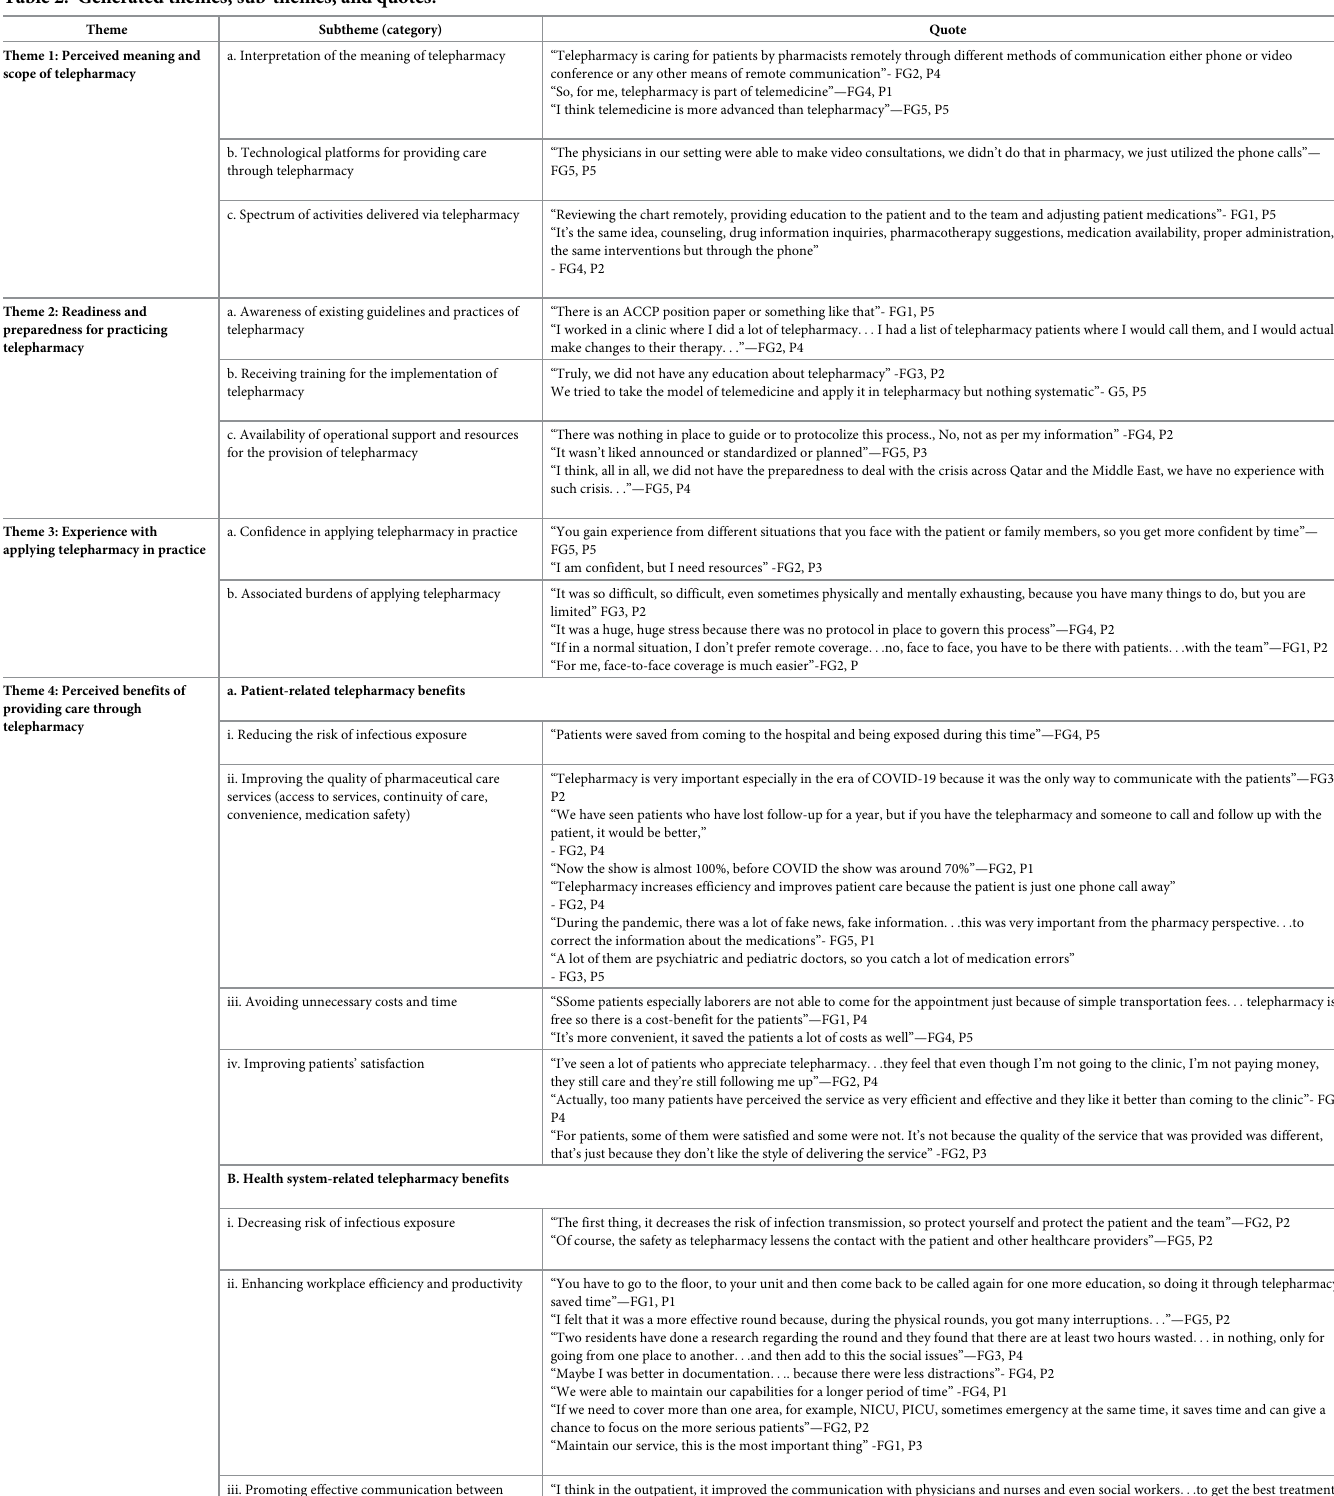
Table 2. Generated themes, sub-themes, and